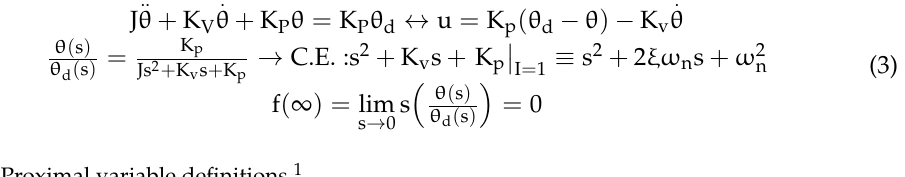
Table 3. Proximal variable definitions 1